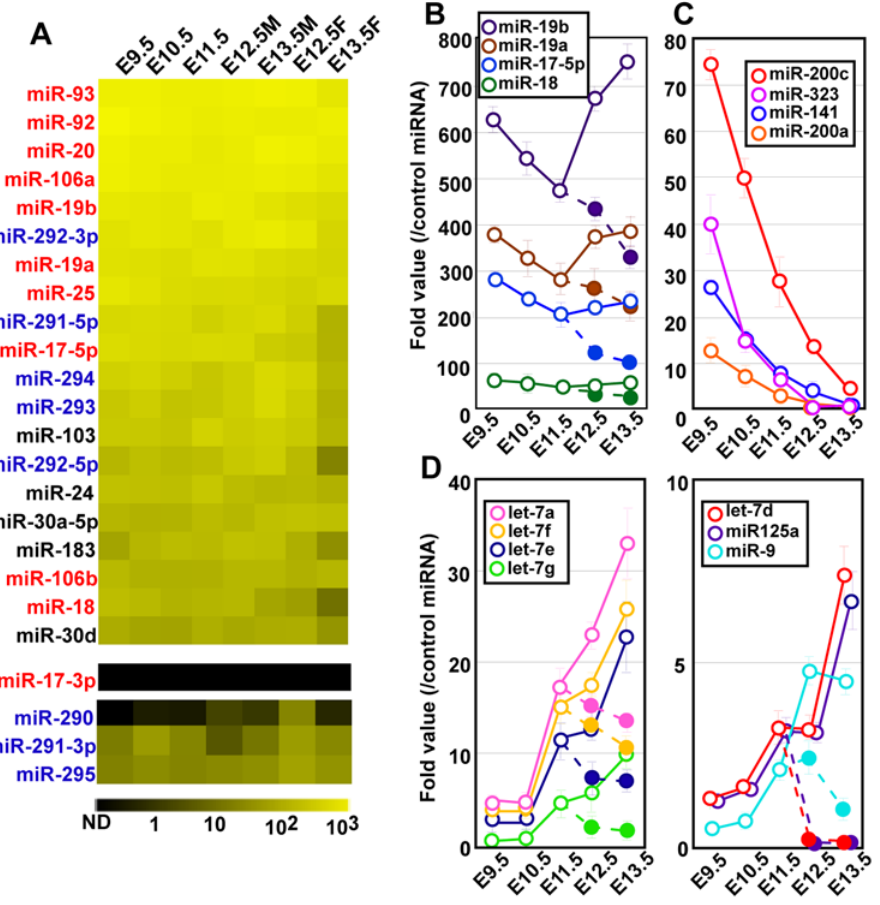
Figure 1. The miRNA expression during PGC development. (A) High expression of miR-17-92 and miR-290-295 clusters. The miRNA levels detected by real-time PCR are represented as a heat map. The intensity of yellow scale corresponds to the level of miRNA expression; black indicates that expression was undetectable. MiRNAs encoded in miR-17-92 and miR-290-295 clusters are marked with red and blue, respectively. (B-D) Alteration of miRNA expression during PGC development. The relative values of miRNA expression in male (solid line and open cycles) and female (broken line and closed circles) after E12.5 are shown. Until E11.5, the sex of PGCs was not determined. Relative values were calculated by dividing the raw value of the individual miRNA by that of the recombinant miR-16 as its levels were pre-determined in the